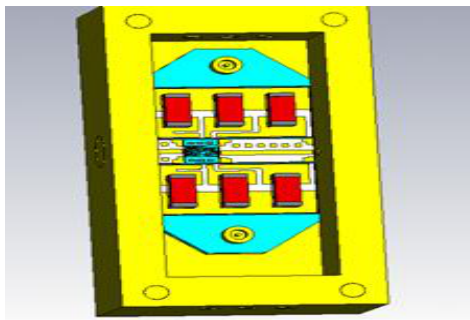
Figure 1: Model of actual Test Box with LNA MMIC